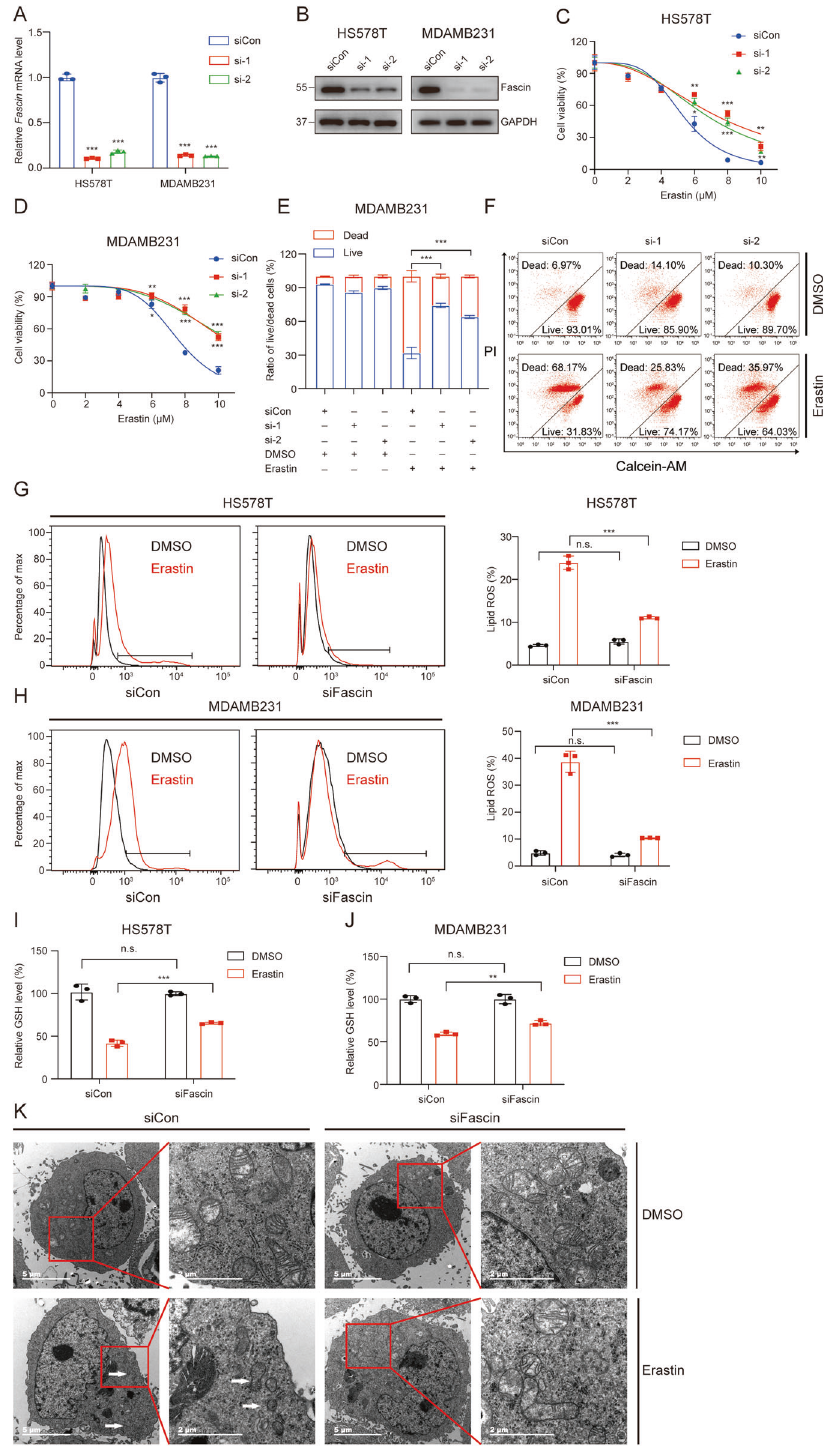
Fig. 3 Fascin silencing inhibits ferroptosis sensitivity in the HS578T and MDAMB231 cell lines. The effects of Fascin knockdown on mRNA ( A ) and protein ( B ) levels compared to negative controls. HS578T ( C ) and MDAMB231 ( D ) cell lines transfected with Fascin siRNAs or siCon were incubated with the indicated concentrations of erastin for 48 h and then assayed for cell viability. E , F MDAMB231 cell lines transfected with Fascin siRNAs or siCon were incubated with erastin (7.5 μ M) for 48 h and then assayed to fl ow cytometry analysis for cell live/dead double staining. HS578T ( G ) and MDAMB231 ( H ) cell lines transfected with Fascin siRNAs or siCon were incubated with erastin (5 μ M) for 24 h, stained with C11-BODIPY, and then subjected to fl ow cytometry analysis. HS578T ( I ) and MDAMB231 ( J ) cell lines transfected with Fascin siRNAs or siCon were incubated with erastin (0.25 μ M) for 48 h and then assayed for GSH levels. K MDAMB231 cells transfected with Fascin siRNAs or siCon were incubated with erastin (5 μ M) for 24 h and then used for TEM analysis. The white arrows show dysmorphic mitochondria (smaller mitochondria, condensed membrane, and decreased cristae). n.s. not signi fi cant. * p < 0.05, ** p < 0.01, and *** p < 0.001. The data are displayed as the means ± s.d of three independent experiments.